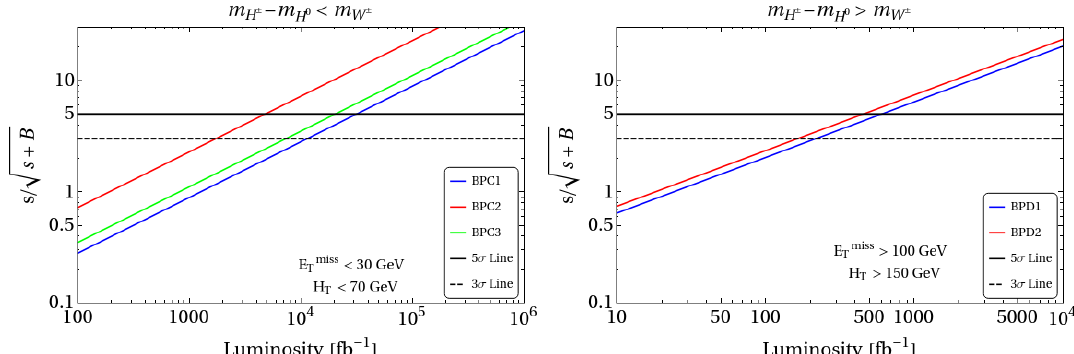
p s = 14 TeV, in terms